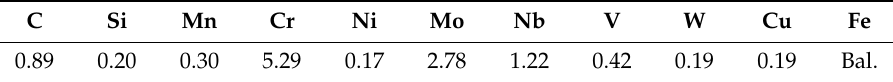
Table 1. Chemical composition of the tool steel powder (wt. %)